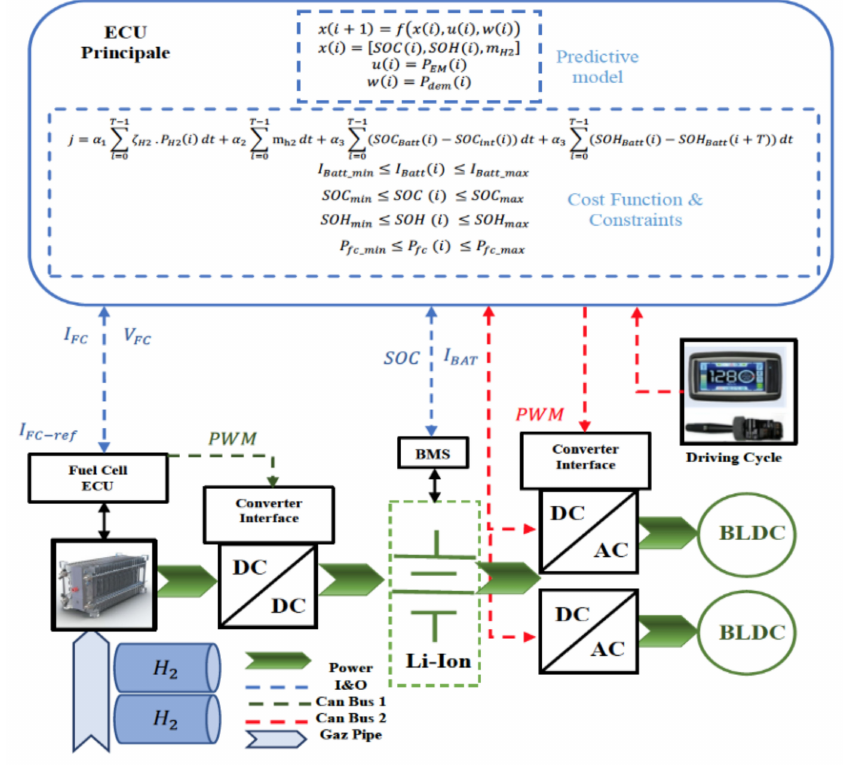
Figure 1. Synoptic diagram of the Moby Post